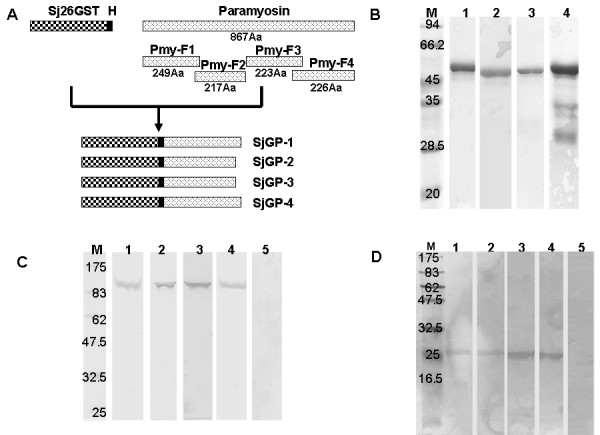
Schematic representation of chimeric gene constructs, recombinant proteins and interaction of immune sera with native proteins. (A) Schematic representation of SjGP-1, SjGP-2, SjGP-3, and SjGP-4 gene construction. Paramyosin was divided into four overlapping fragments and the length of amino acid (Aa) sequence of each fragment is indicated. Each paramyosin fragment was fused to Sj26GST to generate chimeric gene via a hinge (H) consisting of six amino acid residues that were the thrombin recognition site. (B) Purity analysis of purified chimeric proteins by SDS-PAGE. Lane M: molecular mass maker; lanes 1 to 4: purified SjGP-1, SjGP-2, SjGP-3, and SjGP-4 protein, respectively. (C) Interaction of immune sera against the individual chimeric proteins with soluble worm antigen preparation (SWAP) by Western Blot. The SWAP material was separated by SDS-PAGE and analyzed by Western Blot using either immune sera to the individual chimeric proteins or negative control sera. Lane M: molecular mass maker; lanes 1 to 4: sera of mice immunized with SjGP-1, SjGP-2, SjGP-3, and SjGP-4, respectively; lane 5: serum from PBS control mice. (D) Interaction of immune sera against the individual chimeric proteins with purified native Sj26GST. The purified native Sj26GST was separated by SDS-PAGE and analyzed by Western Blot using either immune sera to individual chimeric protein or negative control sera. Lane M: molecular mass maker; lanes 1 to 4: sera of mice immunized with SjGP-1, SjGP-2, SjGP-3, and SjGP-4, respectively; lane 5: serum from PBS control mice.